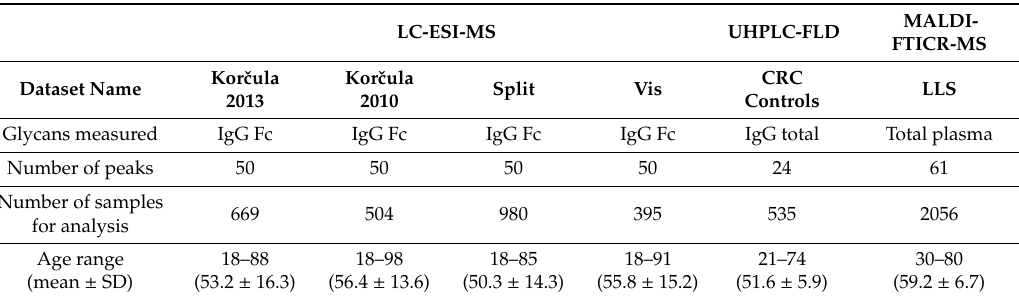
Table 1. Summary of